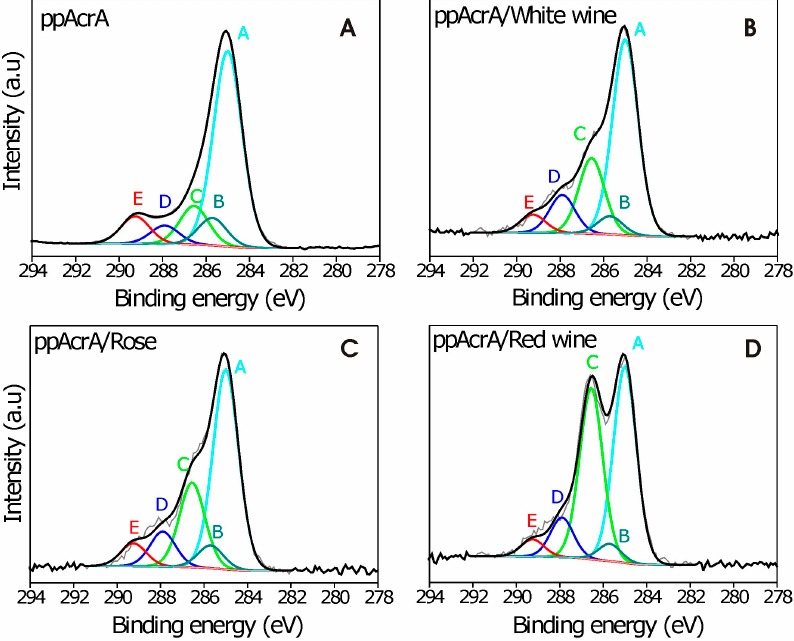
Figure 2. High resolution C1s spectra of different samples: ( A ) acrylic acid plasma polymerized surface (ppAcrA); ( B ) white wine; ( C ) rosé wine, and ( D ) red wine after adsorption on ppAcrA surface.